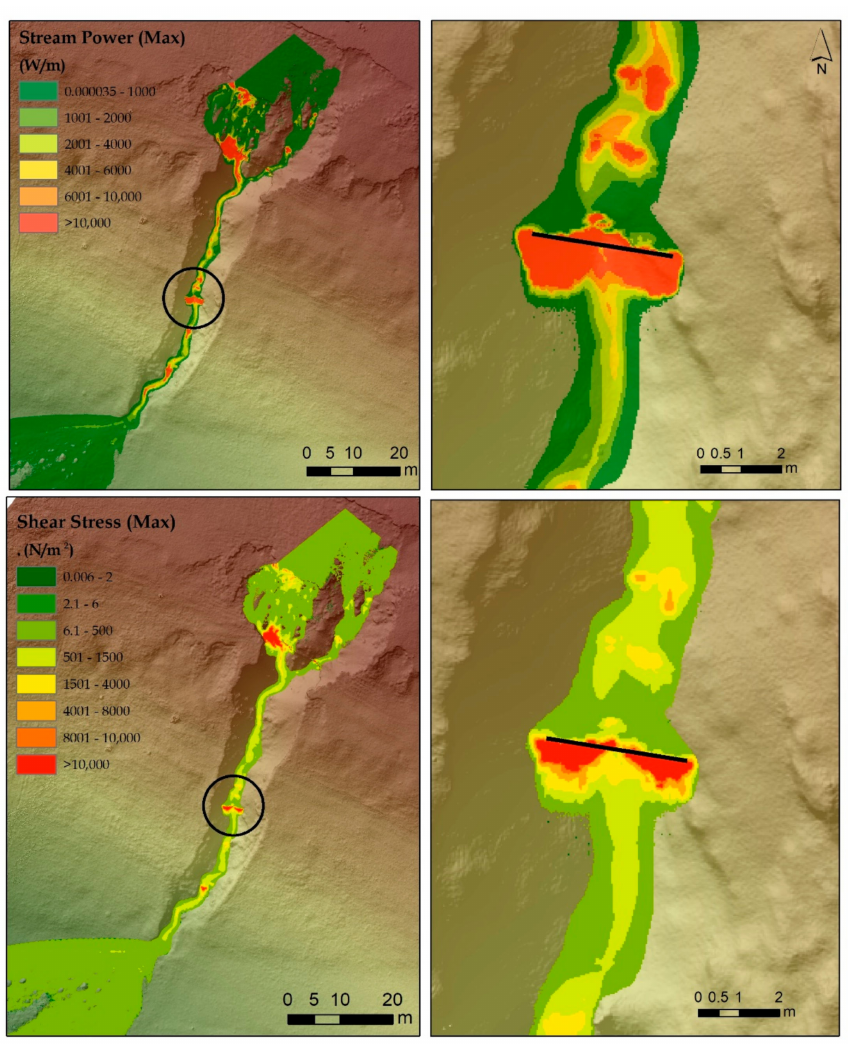
Figure 13. Results of simulation